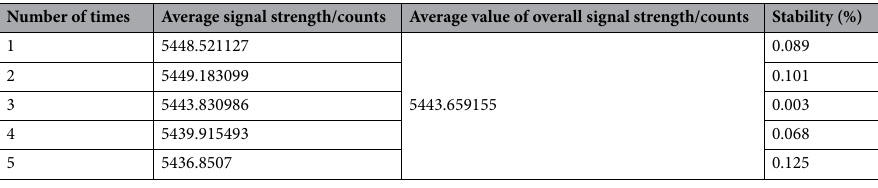
Table 3. Signal strength